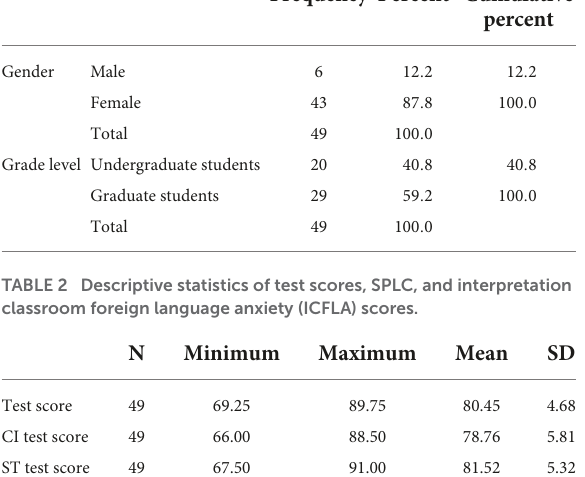
TABLE 1 Descriptive statistics of gender and grade level.